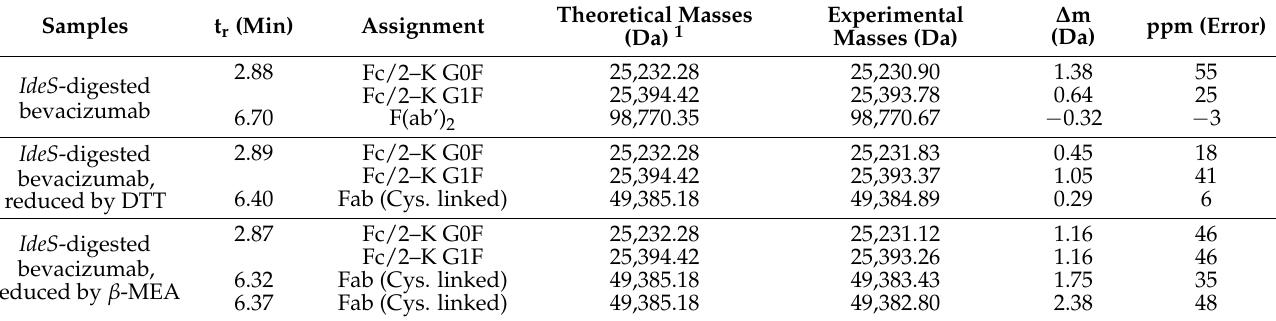
Table 1. Fragments retention times and mass assignments performed by